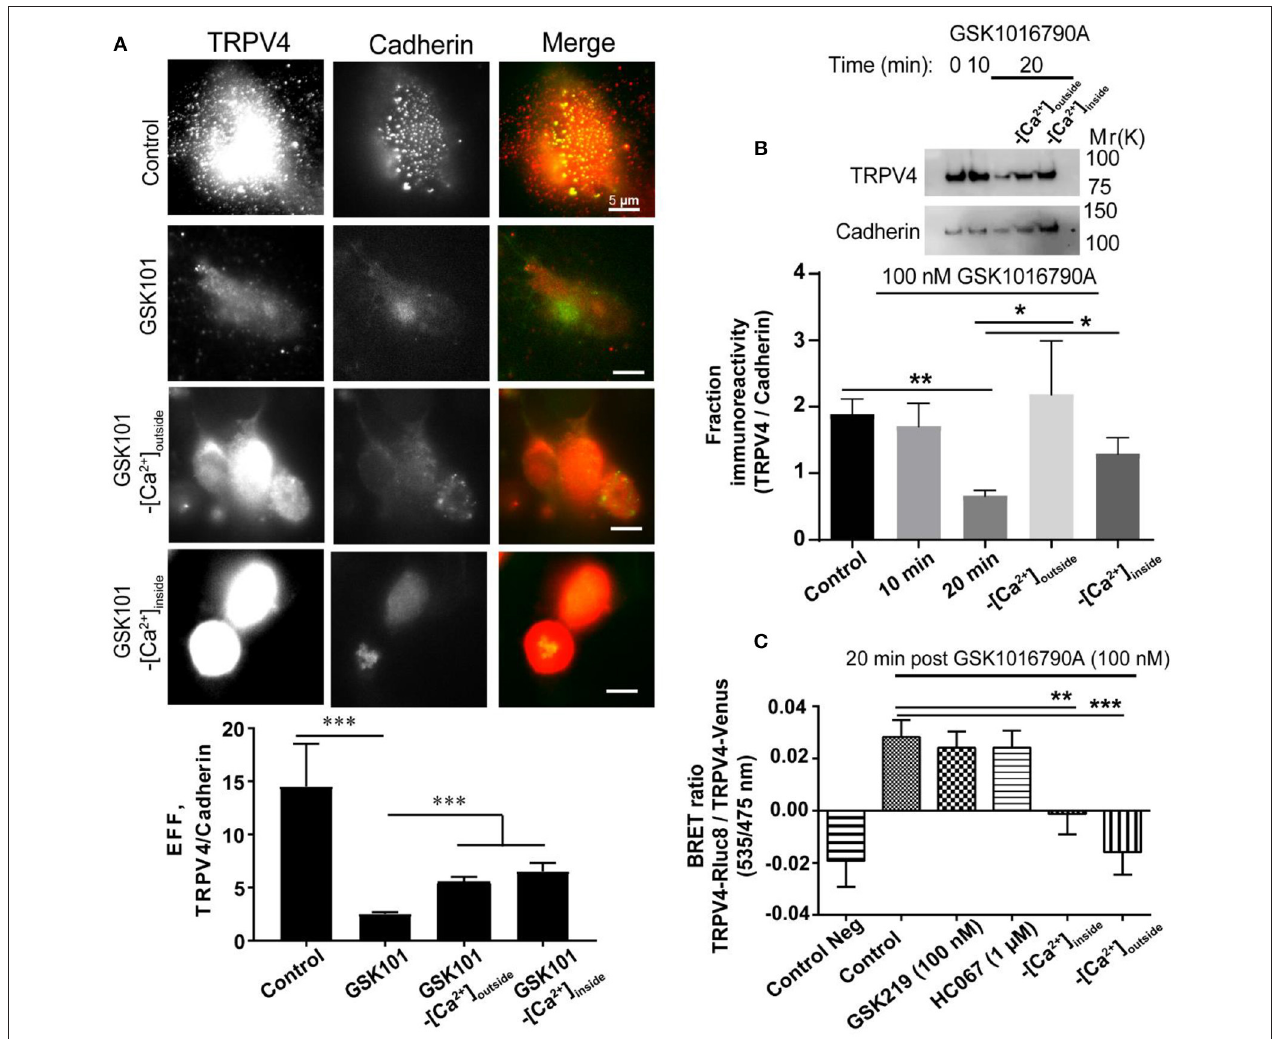
FIGURE 3 | The internalization of TRPV4 post-GSK1016790A stimulation is Ca 2 + dependent (A) TIRF microscopy and (B) Cell surface biotinylation assay in HUVECs showed that TRPV4 stimulation with GSK1016790A reduces the membrane density of TRPV4 channels while depletion of calcium from the stores or removal of the calcium from the buffer inhibits this internalization. (C) BRET assay in HEK293 cells expressing TRPV4-Rluc8 and TRPV4-Venus showed that depletion of calcium from the stores (-[Ca 2 + ] inside ) with 1 µ M thapsigargin or removal of the calcium from the buffer (-[Ca 2 + ] outside ) reduces the aggregation of TRPV4 channels post-GSK1016790A stimulation while inhibition of TRPV4 with GSK2193874 (GSK219) and HC067047 (HC067) did not have any effect. Data are representative of at least four independent experiments. * p < 0.05, ** p < 0.01, and *** p <